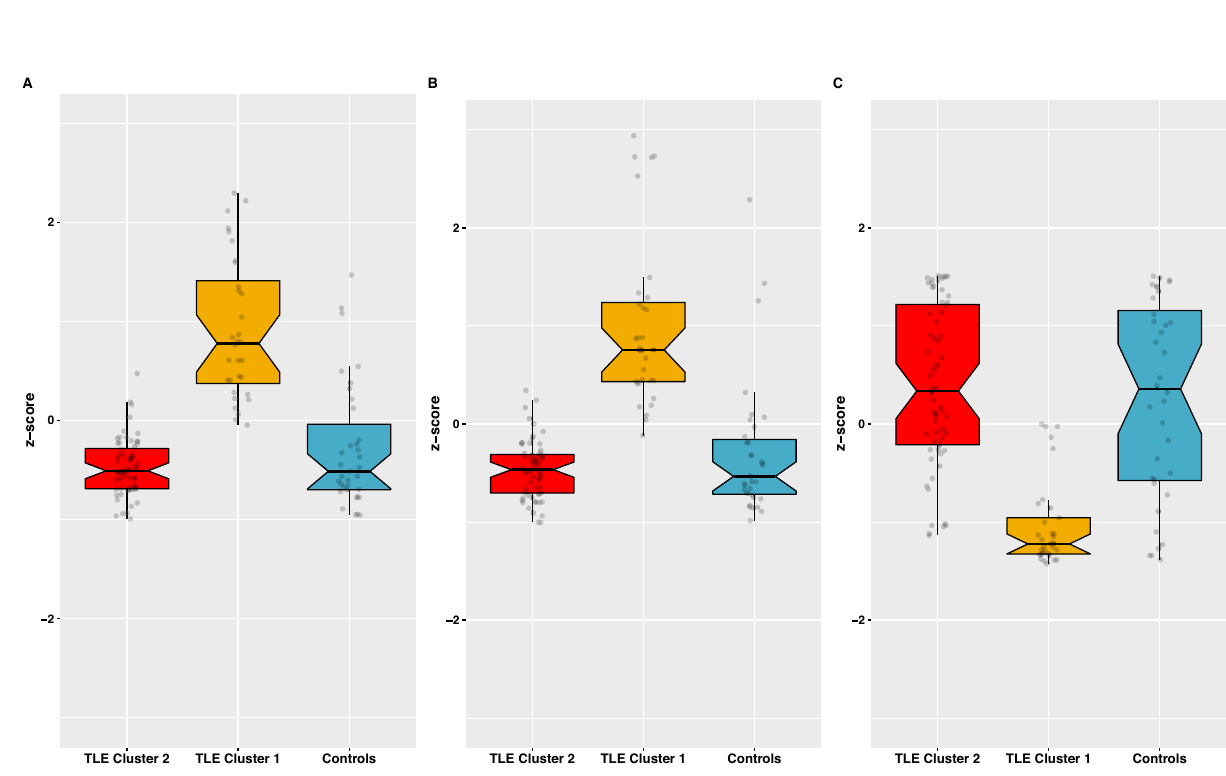
Figure 2. ( A ) Local efficiency, ( B ) Global efficiency, and ( C ) modularity index across ML-derived TLE clusters (red and yellow) and healthy controls (blue) for morphological